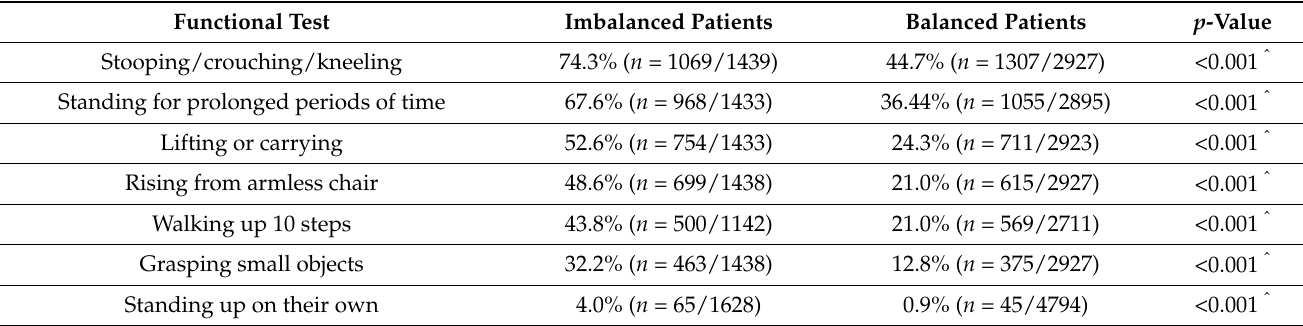
Table 4. Comparison of proportion of Imbalanced and Balanced patients reporting difficulty during physical assessment and performance